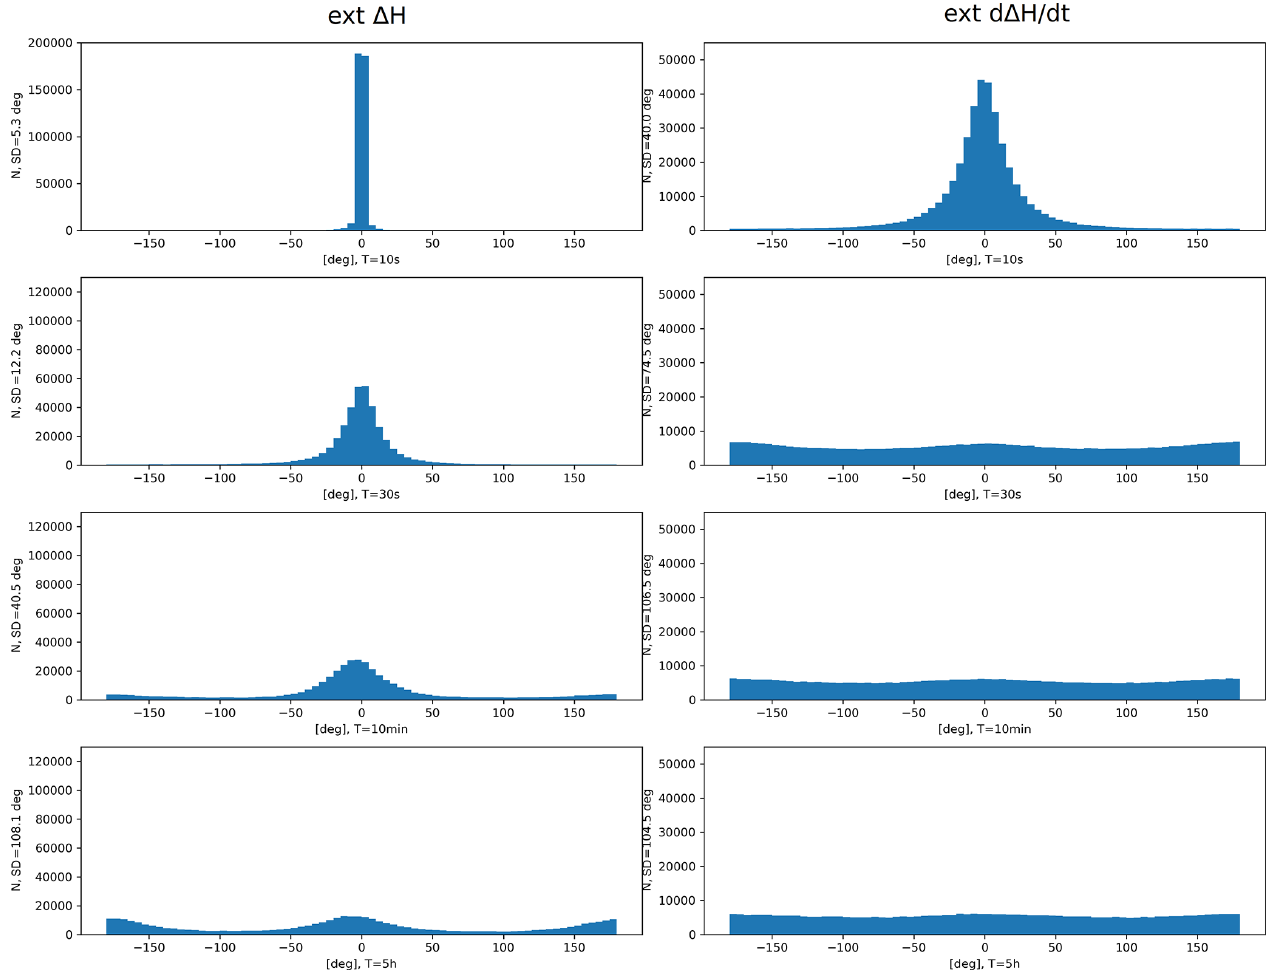
Figure 13. Examples of (cid:49)θ distributions of external (cid:49) H (left panel) and external d (cid:49) H / d t (right panel) at Kiruna (KIR) with different values of T . From top to bottom: T = 10, 30s, 10min and 5h. The distributions even out at greater T